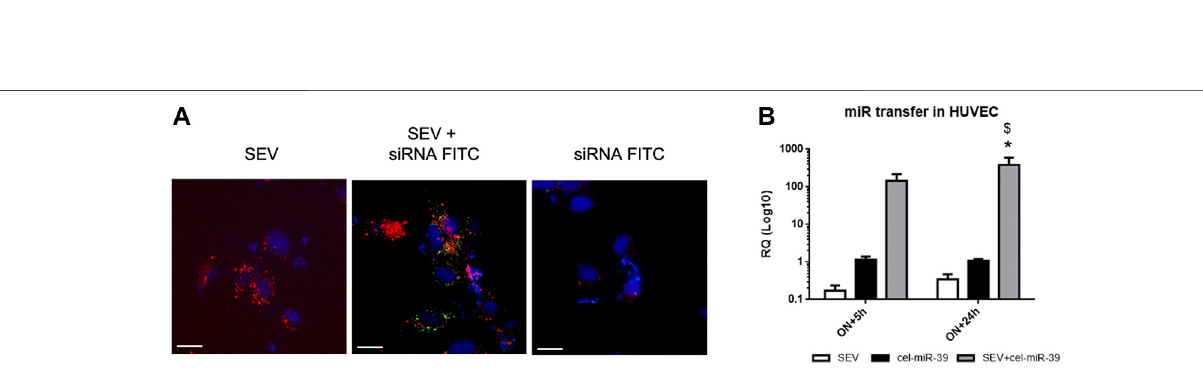
FIGURE 1 | Characterization of SEVs co-incubated with exogenous cel-miR-39. (A) Scheme of co-incubation protocol. (B) TEM images of SEVs (SEV) and SEV + cel-miR-39.Blackarrowsindicatethespeci fi cbindofcel-miR-39probe.Blackline,100 nm. (C) NTArepresentativepro fi leofSEVsbefore(SEVPre)andafter(SEVPost) washingstepwith50 kDaconcentrator. (D) NTAanalysisofparticlesnumberofSEVsbeforeandafter washingstep. Thesamepro fi leand quanti fi cationwereobserved whenSEVswerewashedwithdialysismembrane.Dataareexpressedasmean ± SD. (E) SEVsurfacemarkerexpressionwasanalyzedbyFACS.+:lowexpression < 15%;++:medianexpression15 – 50%;+++:highexpression > 50%;-negativeexpression. (F) WesternblotanalysisofCD63,CD81,Ago2andANXA2ontwodifferent SEV pools (EV S1 and EV S2).